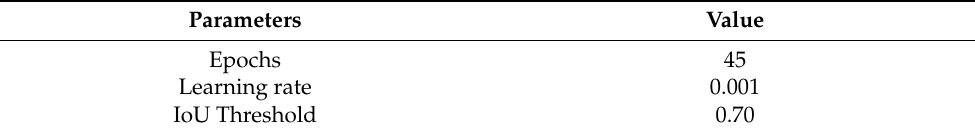
Table 1. Training parameters of the presented technique.